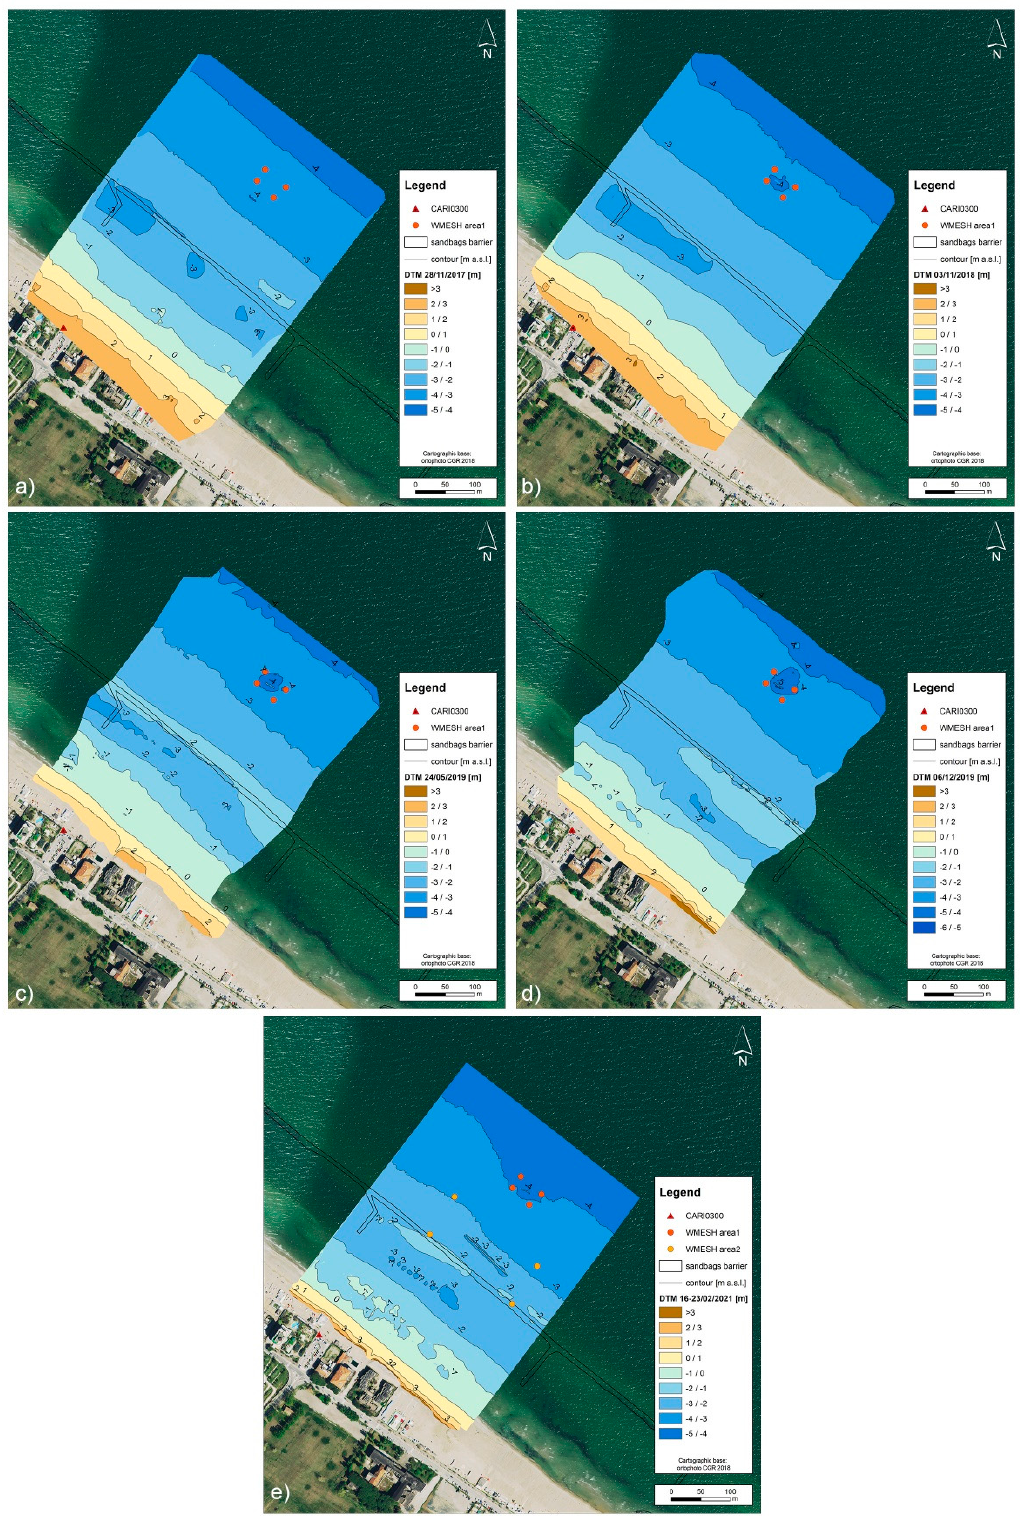
Figure 6. DTMs of the surveyed beach on: ( a ) 28 November 2017; ( b ) 3 November 2018; ( c ) 24 May 2019; ( d ) 6 December 2019; ( e ) 16 February 2021. The location of the submerged sandbag barrier, derived from aerial photographs [23], is indicated by black lines parallel to the beach at about − 2 m. Red and orange dots indicate the areas of installation of W-Mesh structures (see text for details); the red triangle indicates the CARI0300 benchmark position on the backshore.